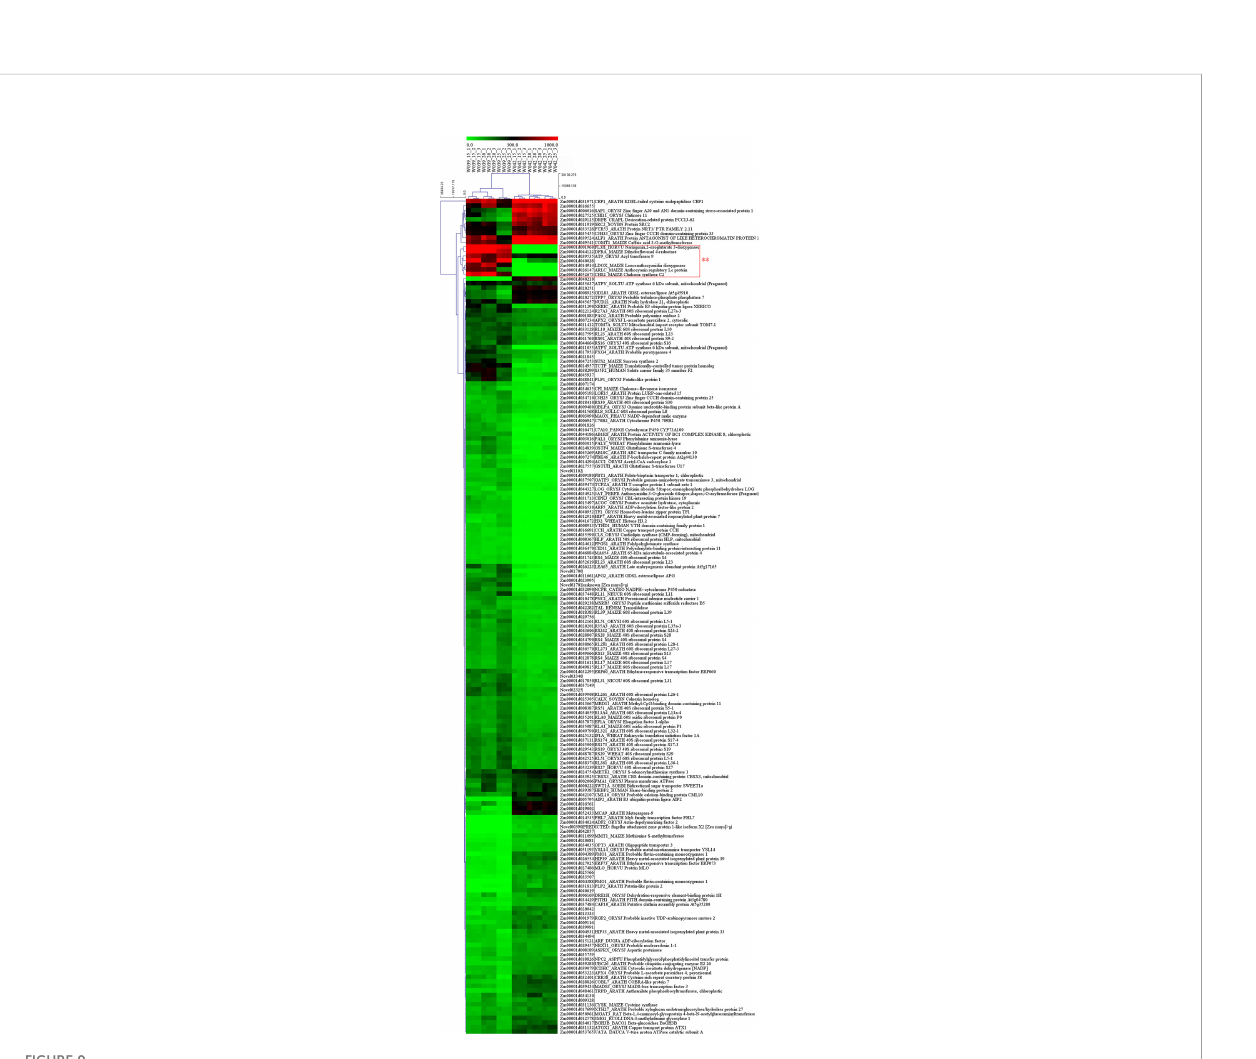
FIGURE 9 The expression pattern of 183 genes in cyan module. The heatmap represents the FPKM values from RNA sequencing data. The genes in the red square frame marked with double asterisks were categorized to one group and mainly participated in the anthocyanins